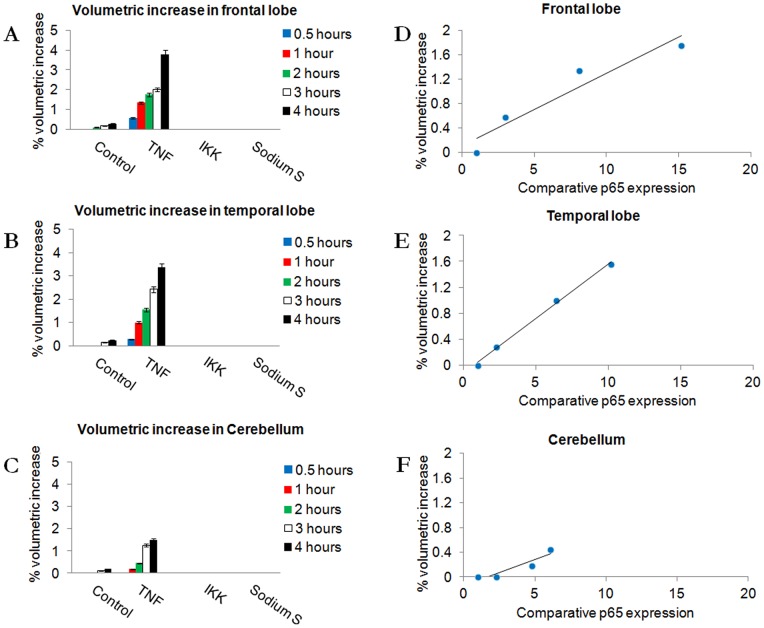
Quantification of inflammation induced by TNF-α.Tissue inflammation in Control (Ctrl), 10 ng/ml TNF-α (TNF), TNF-α with IKK Inhibitor (IKK), and TNF-α with sodium salicylate samples (Sodium S). A–C: Measurements at 0.5, 1 and 2 hours stimulation and after TNF-α removal (3 and 4 hours). Results are presented as for figure 1, data is significant after 2 hours of stimulation (F = 22.53; p = 0.001; df = 3,96). D-F: Plot of % volumetric increase of tissue vs. normalized overall expression of NF-κB p65 from quantification of Western blot samples with a superimposed line of linear regression.